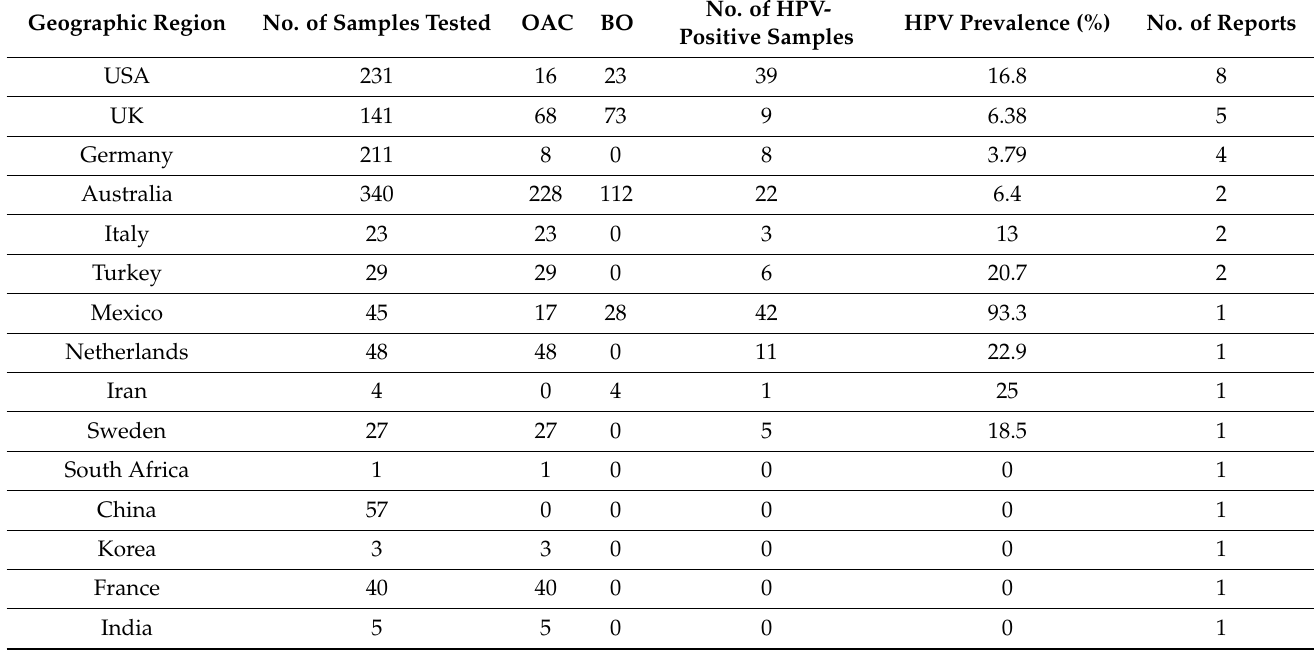
Table 1. Studies included in systematic review by Kunzman et al. (with permission)